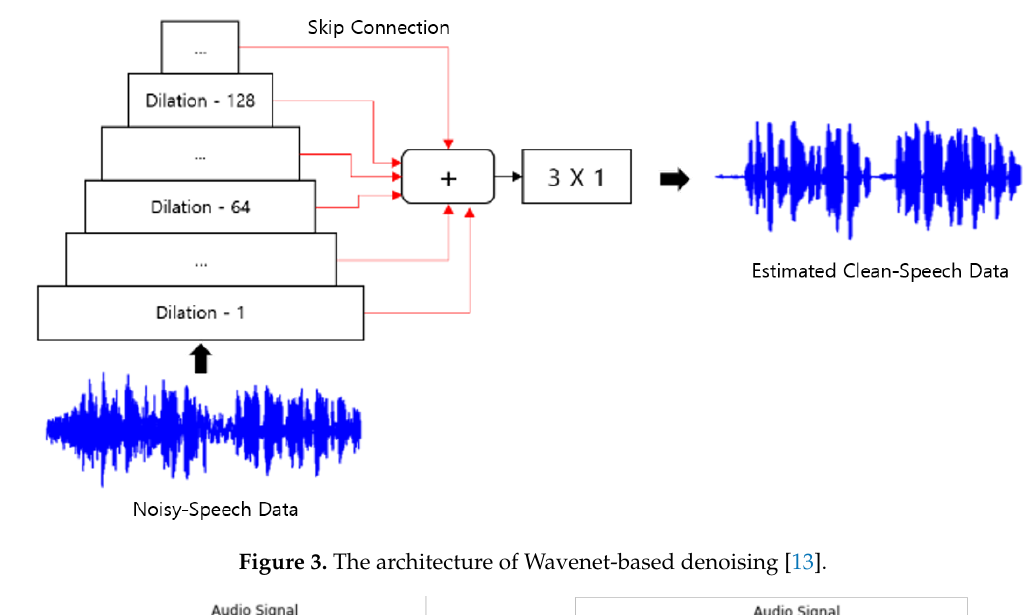
Figure 3. The architecture of Wavenet-based denoising [13].